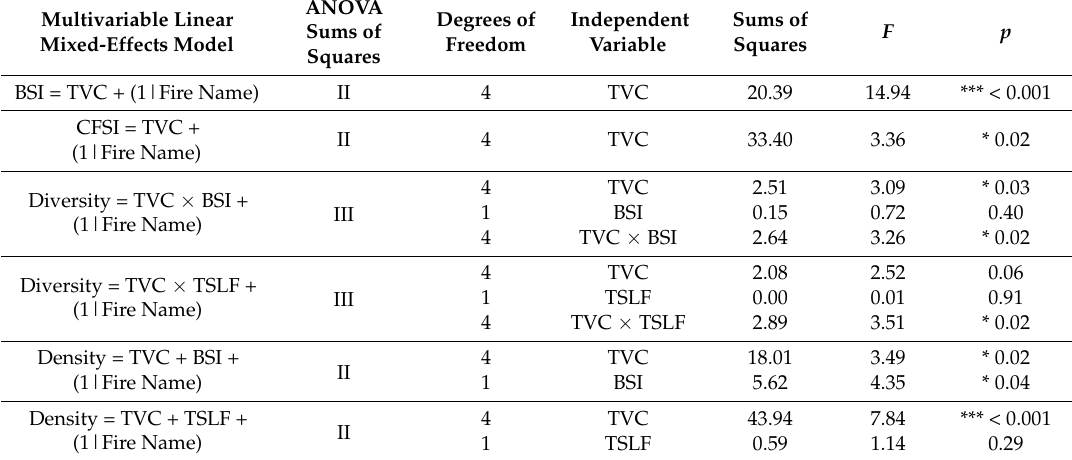
Table 4. Multivariable linear mixed-effects models describing surface Burn Severity Index (BSI), Canopy Fire Severity Index (CFSI), time since last fire (TSLF), topoedaphic vegetation classes (TVC), and ecological outcomes of seedling density and Shannon Diversity Index of understory vascular plant communities. The effect size ( F ) and significance ( p ) of terms are tested with Type II sums of squares where there are no significant interactions, and Type III sums of squares in the presence of a significant interaction. Significance of intendent variables is signified as follows: *** p ≤ 0.001, ** p ≤ 0.01, * p ≤